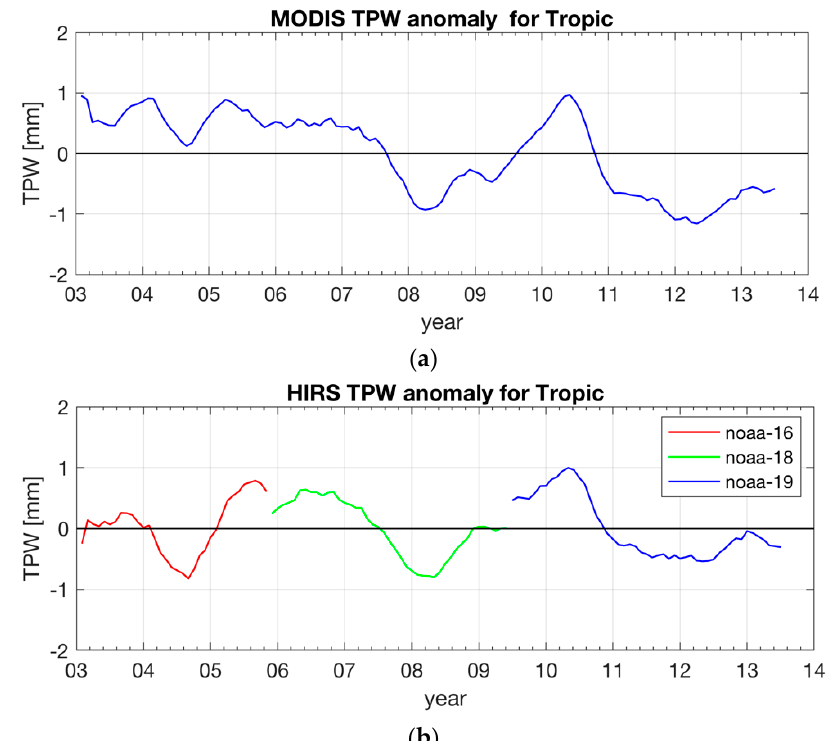
Figure 11. Anomaly of TPW with respect to the mean value for ( a ) MODIS from 2003 through 2013 and ( b ) each HIRS separately from 2003 to 2005 (NOAA-16), 2006 to 2008 (NOAA-18), and 2009 to 2013 (NOAA-19).